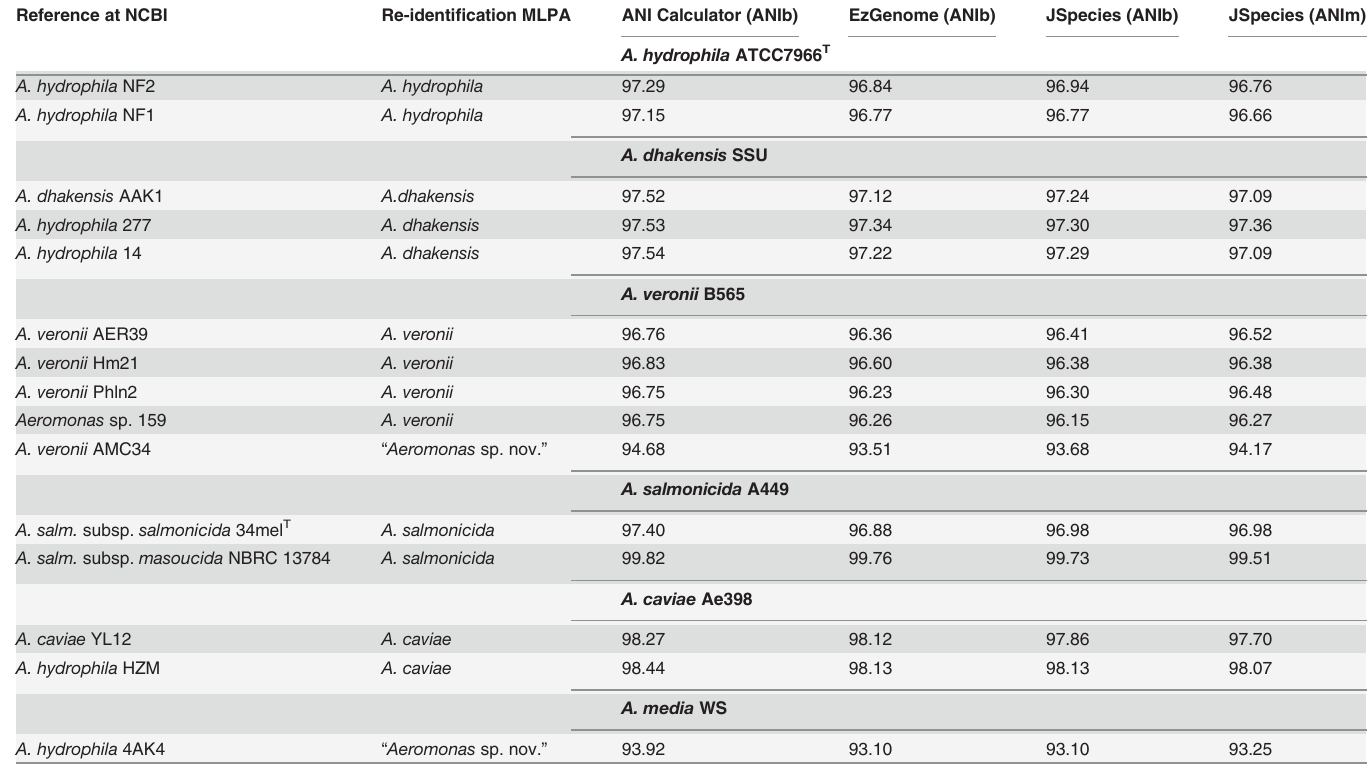
Table 2. ANI results in function of the employed calculating tool for 15 selected Aeromonas genomes against a representative one from the same species. Reference at